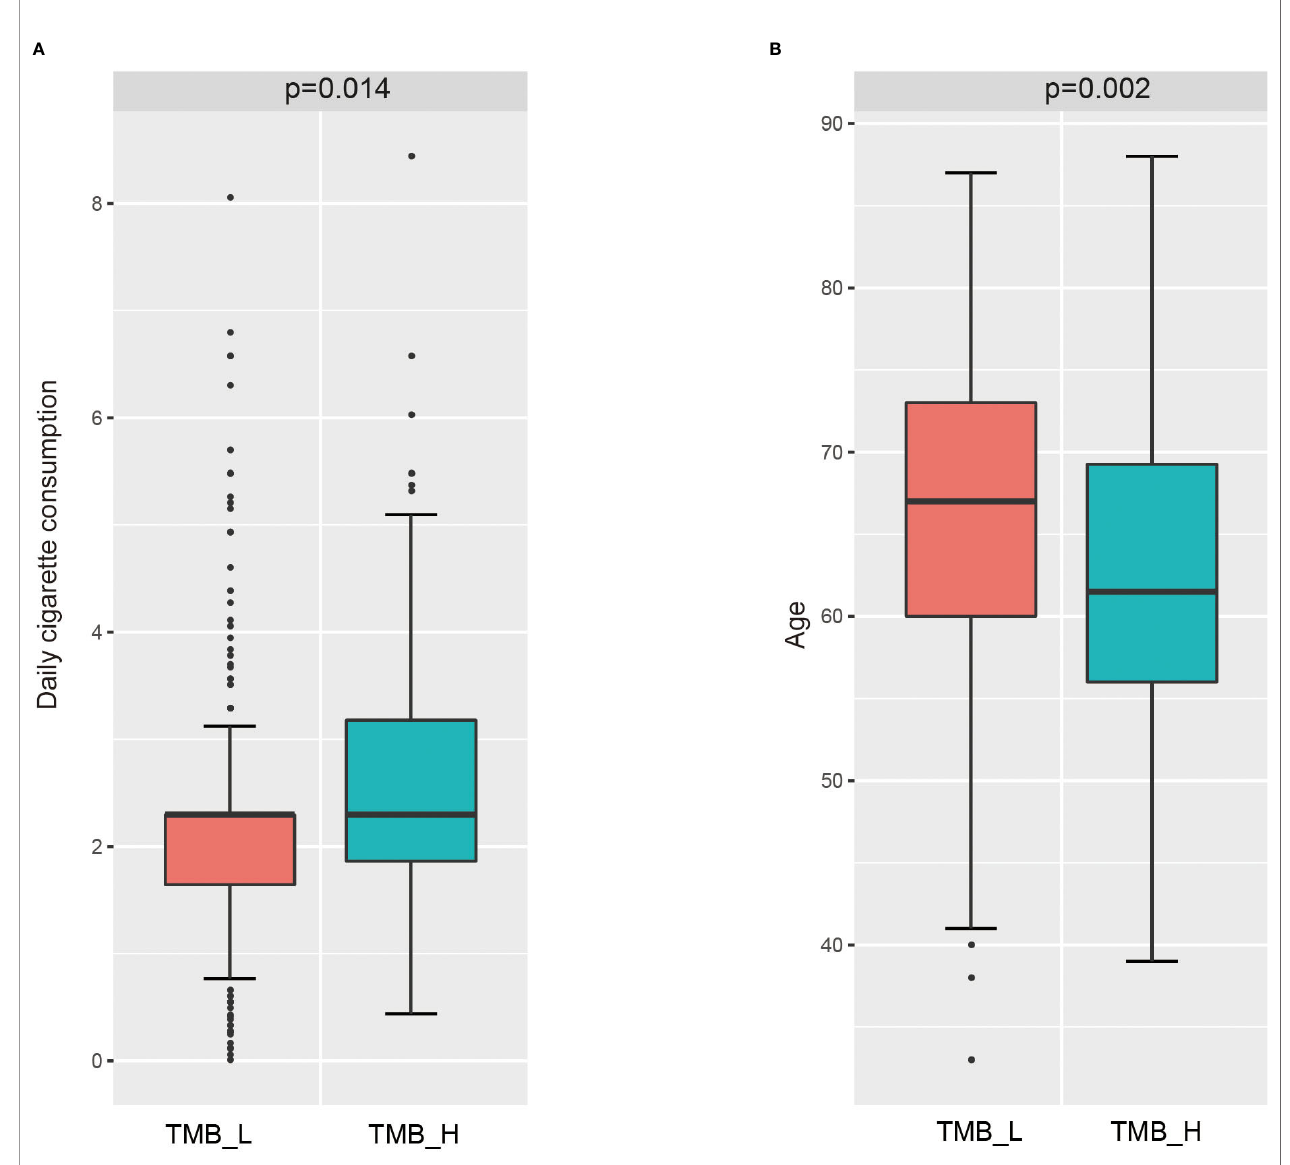
FIGURE 2 | Correlation of several clinical features with TMB status. (A) Correlation analysis between daily cigarette consumption and TMB status. (B) Relationship between ages and TMB